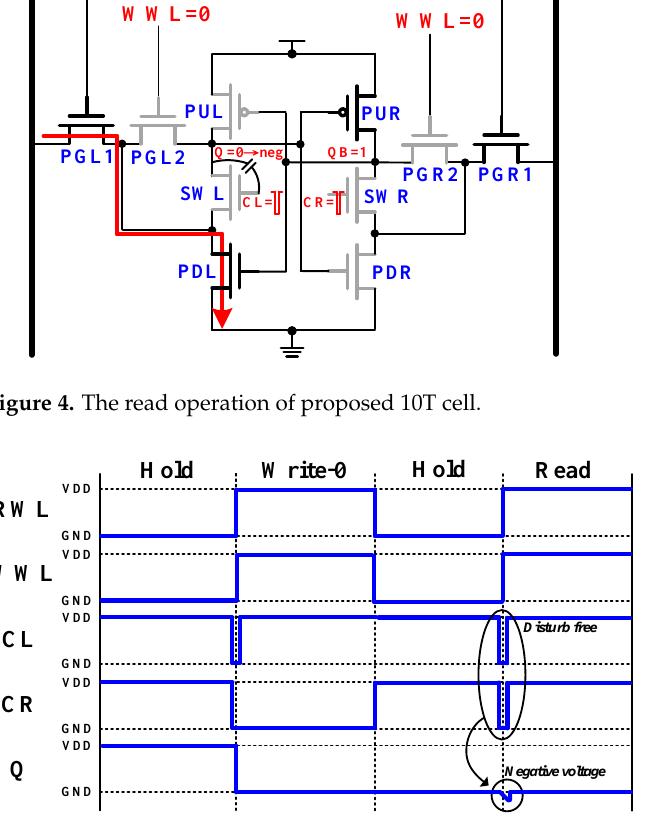
Figure 5. Time-domain waveform diagram of proposed 10T cell.